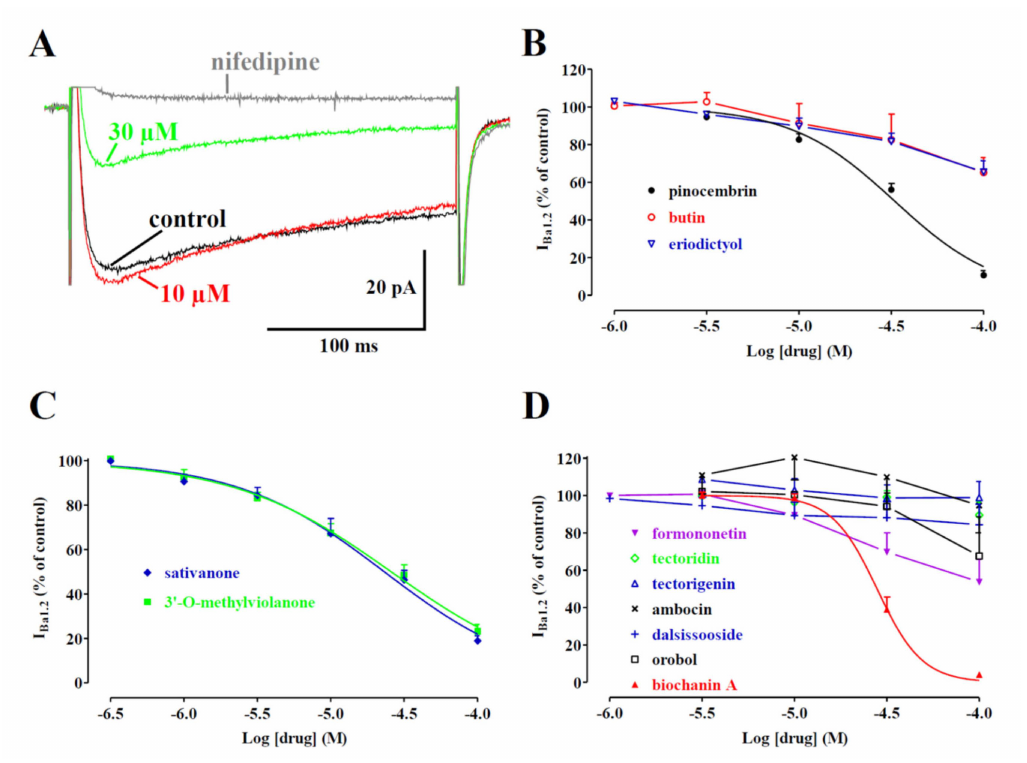
Figure 3. Effects of Dalbergia isolates on I Ba1.2 in single tail artery myocytes: ( A ) average traces (recorded from 5 cells) of I Ba1.2 , elicited with 250 ms clamp pulses to 0 mV from a V h of − 50 mV, measured in the absence (control) or presence of cumulative concentrations of biochanin A; ( B – D ) concentration-dependent effects of ( B ) flavanones, ( C ) isoflavanones, and ( D ) isoflavones. On the ordinate scale, current amplitude is reported as a percentage of the value recorded just before the addition of the first concentration of Dalbergia isolate. The curves show the best fit of the points. Data points are the mean ± SEM ( n =